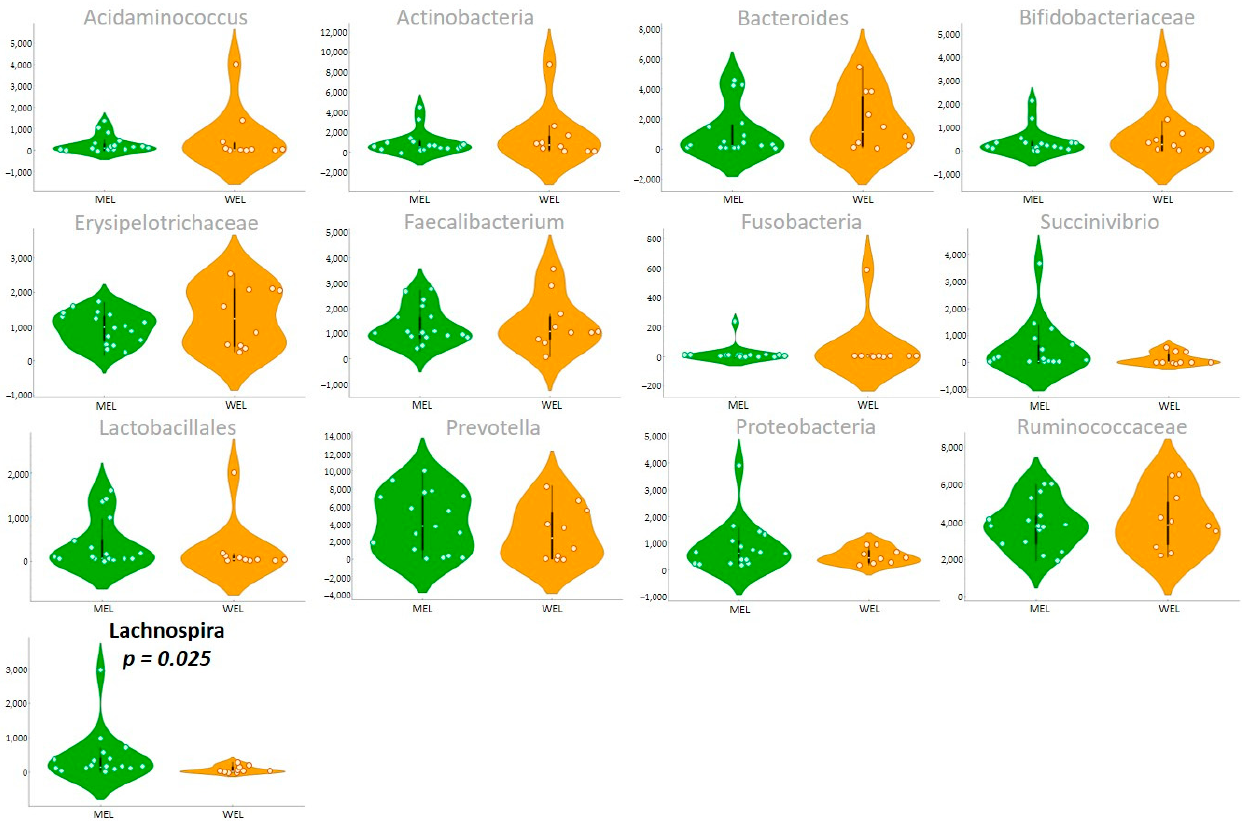
Figure 2. Gut microbiota by dietary pattern.